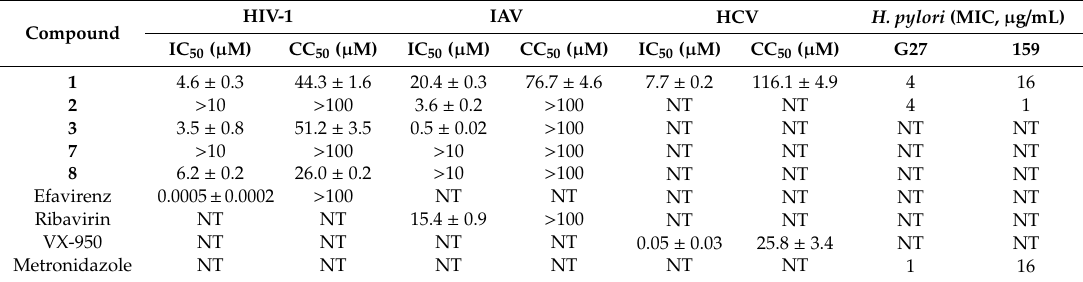
Table 2. Antiviral (IC 50 and CC 50 , µ M) and antibacterial (MIC, µ g / mL) activities of compounds 1 – 3 , 7 , and 8